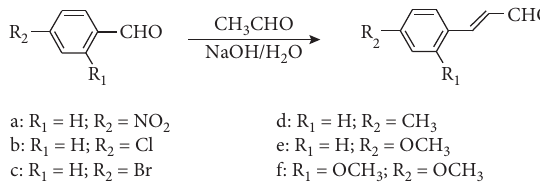
Figure 1: Synthesis of cinnamaldehyde (CA) Table 1: 1 H-NMR (400 MHz, CDCl 3 ) data of cinnamaldehyde (CA) derivatives.